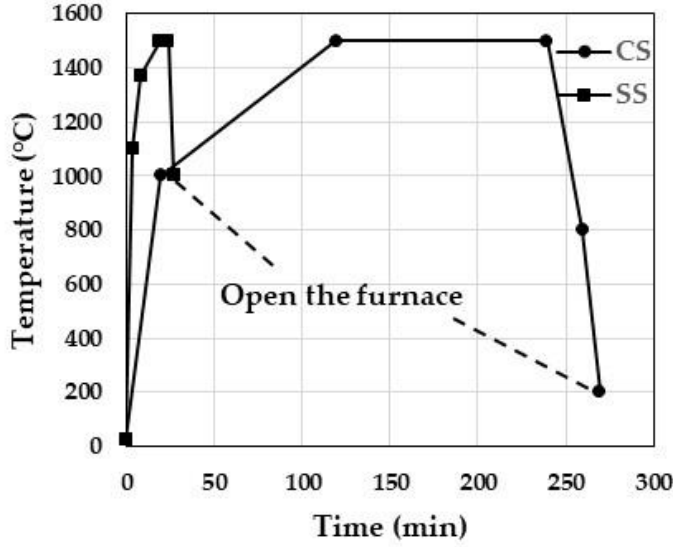
Figure 2. Sintering schedules of conventional sintering (CS) and speed sintering (SS).